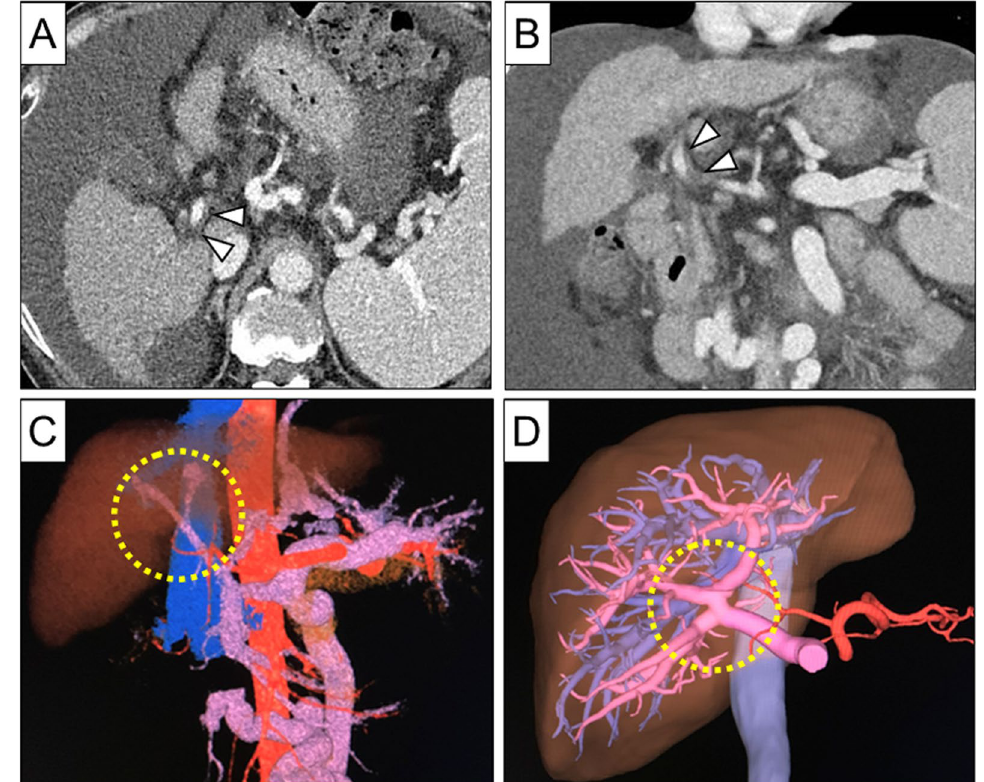
Fig. 1 Preoperative imaging of recipient and donor. A, B Contrast-enhanced computed tomography showed a partially thrombosed main portal vein in the recipient (arrowheads). C Three-dimensional computed tomography showed the recipient’s portal vein which had standard anatomy and was narrowed by portal vein thrombosis (circle). D Three-dimensional computed tomography showed separating right anterior and right posterior portal veins in the donor